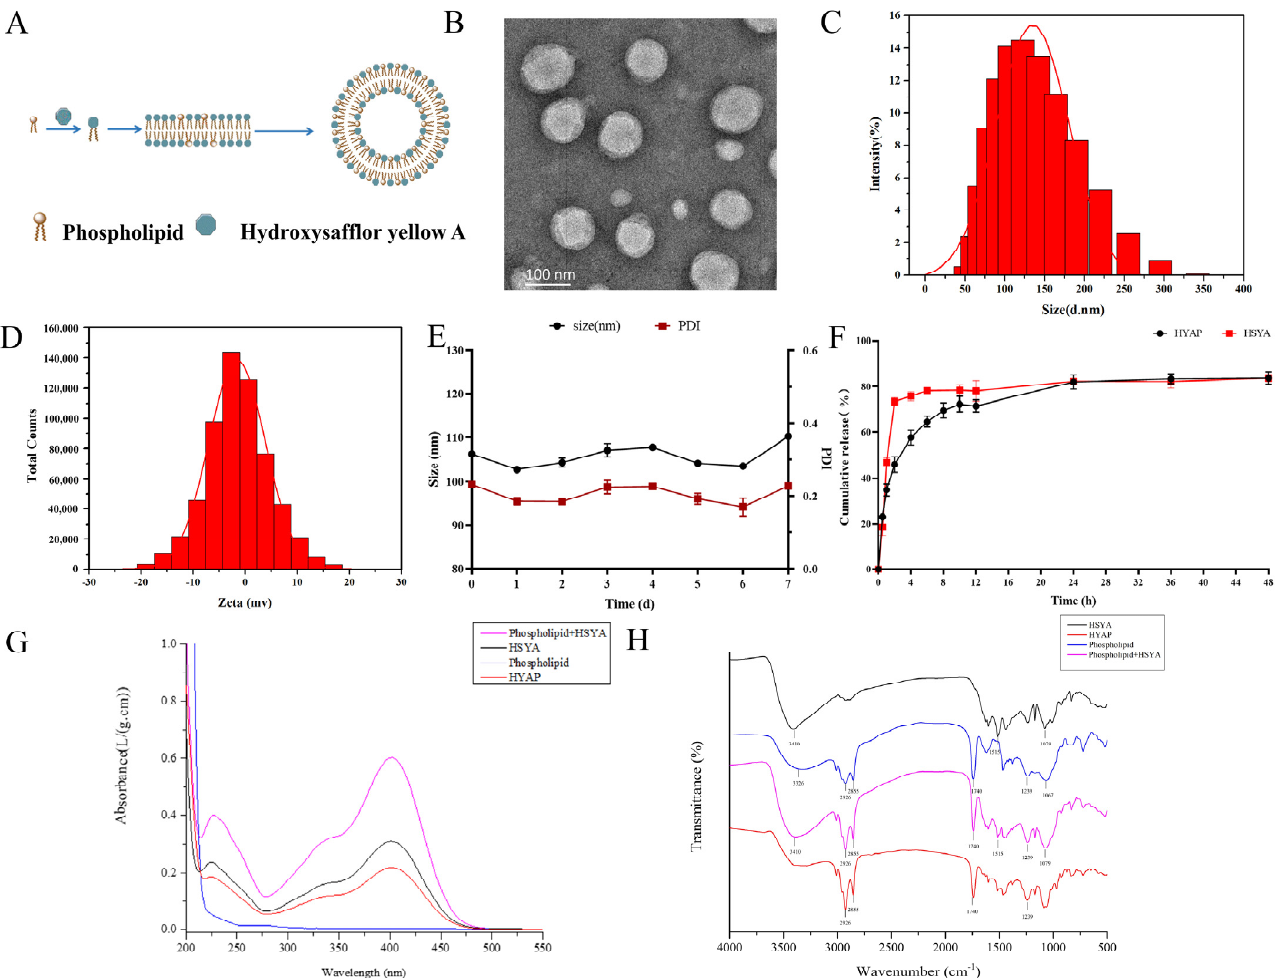
Figure 1. Preparation and characterization of HYAP. ( A ) Schematic diagram of the preparation of HYAP. ( B ) Morphology of HYAP by TEM. Scale bar: 100 nm. ( C ) Size distribution of HYAP by DLS. ( D ) Zeta-potential of HYAP. ( E ) Size and PDI changes of HYAP in seven days. ( F ) Cumulative release rate of HYAP and HSYA in vitro by UV. ( G ) Ultraviolet spectroscopy analysis of HSYA, phospholipids, mixture of HSYA and phospholipids, and HYAP. ( H ) Fourier transform infrared spectroscopy analysis of HSYA, phospholipids, mixture of HSYA and phospholipids, and